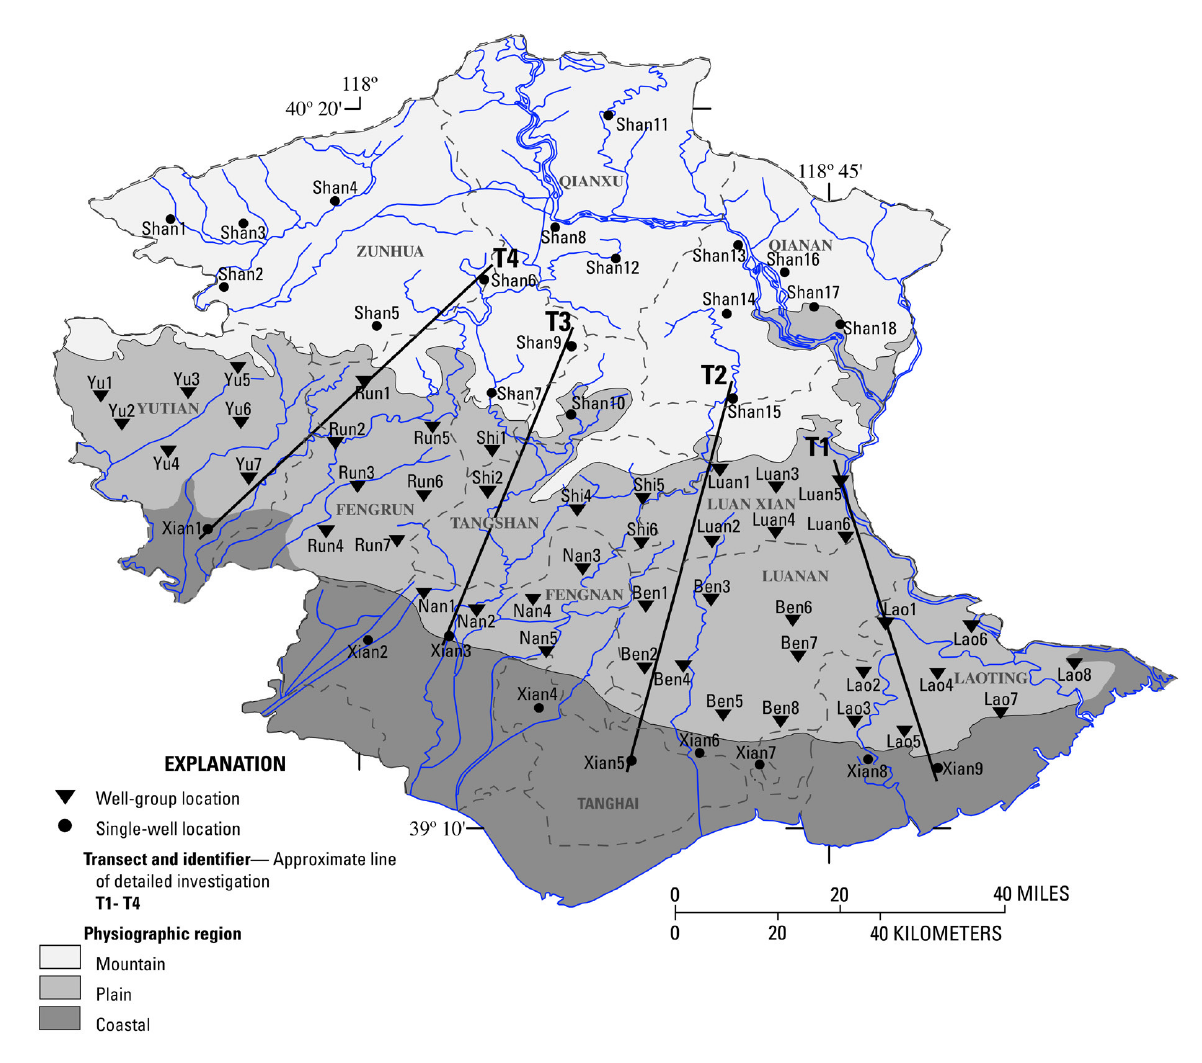
FIGURE 3. Tangshan study area showing locations of wells, transects (T1 through T4) for detailed investigations, county boundaries, and physiographic regions. A well group consists of two or more